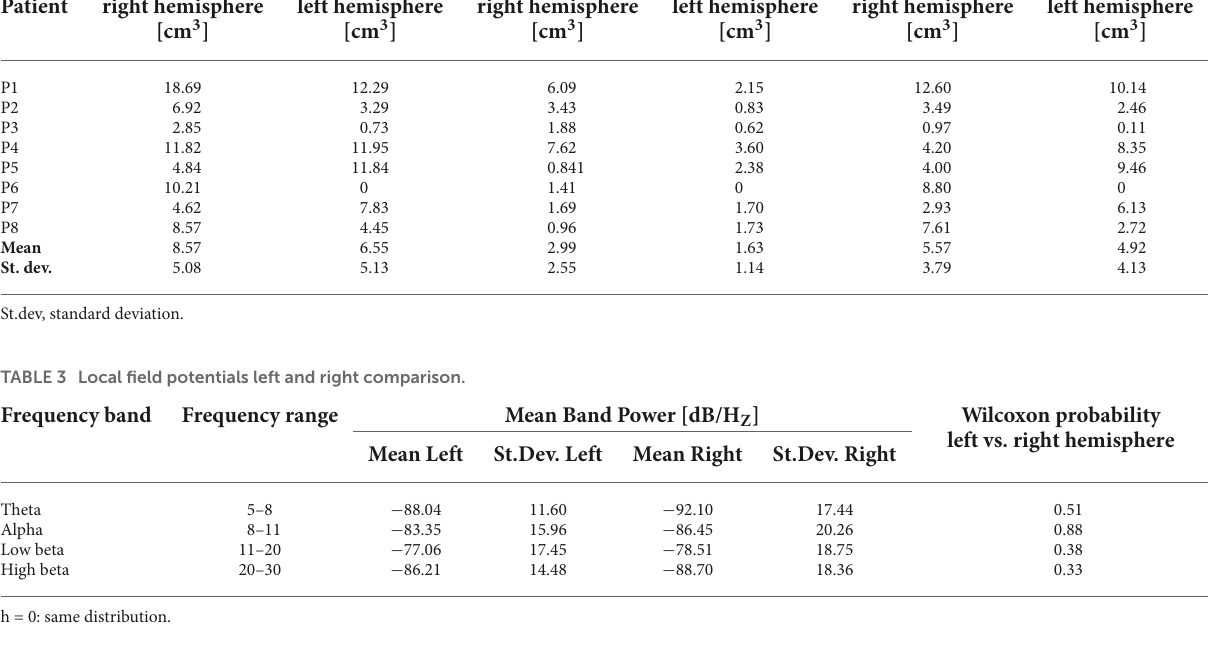
TABLE 2 MRI edema volume.